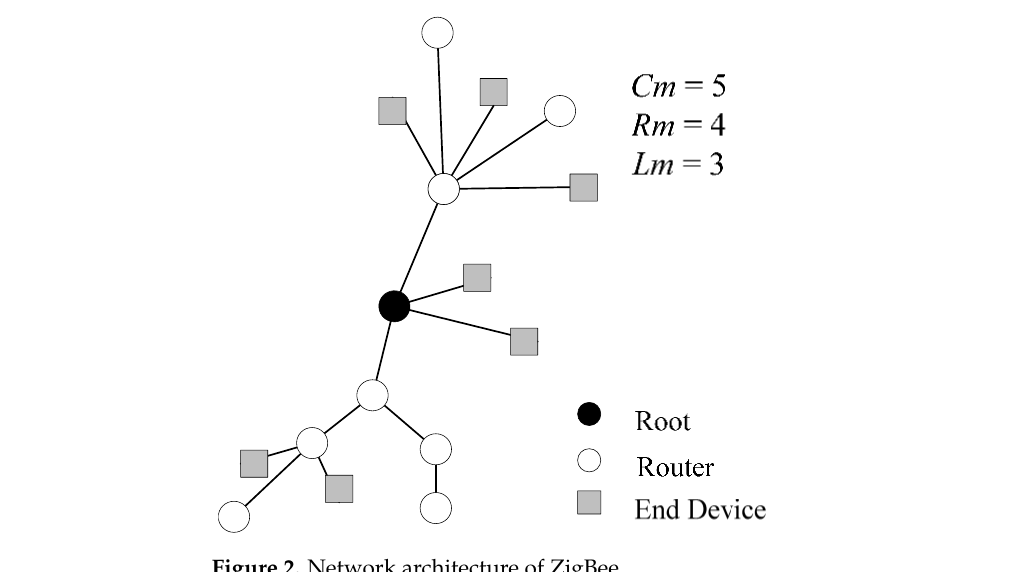
Figure 2. Network architecture of ZigBee.